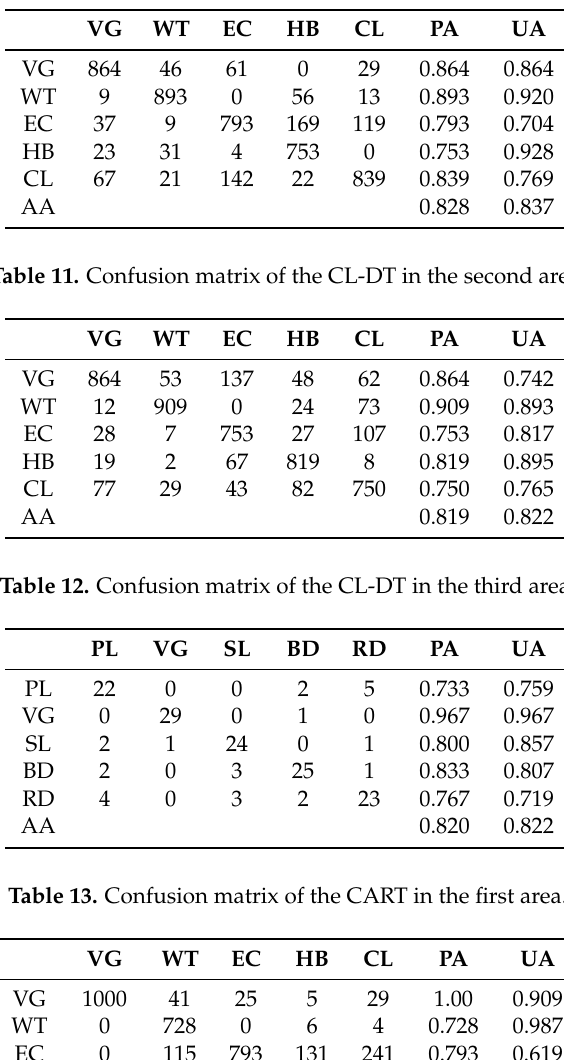
Table 10. Confusion matrix of the CL-DT in the first area.